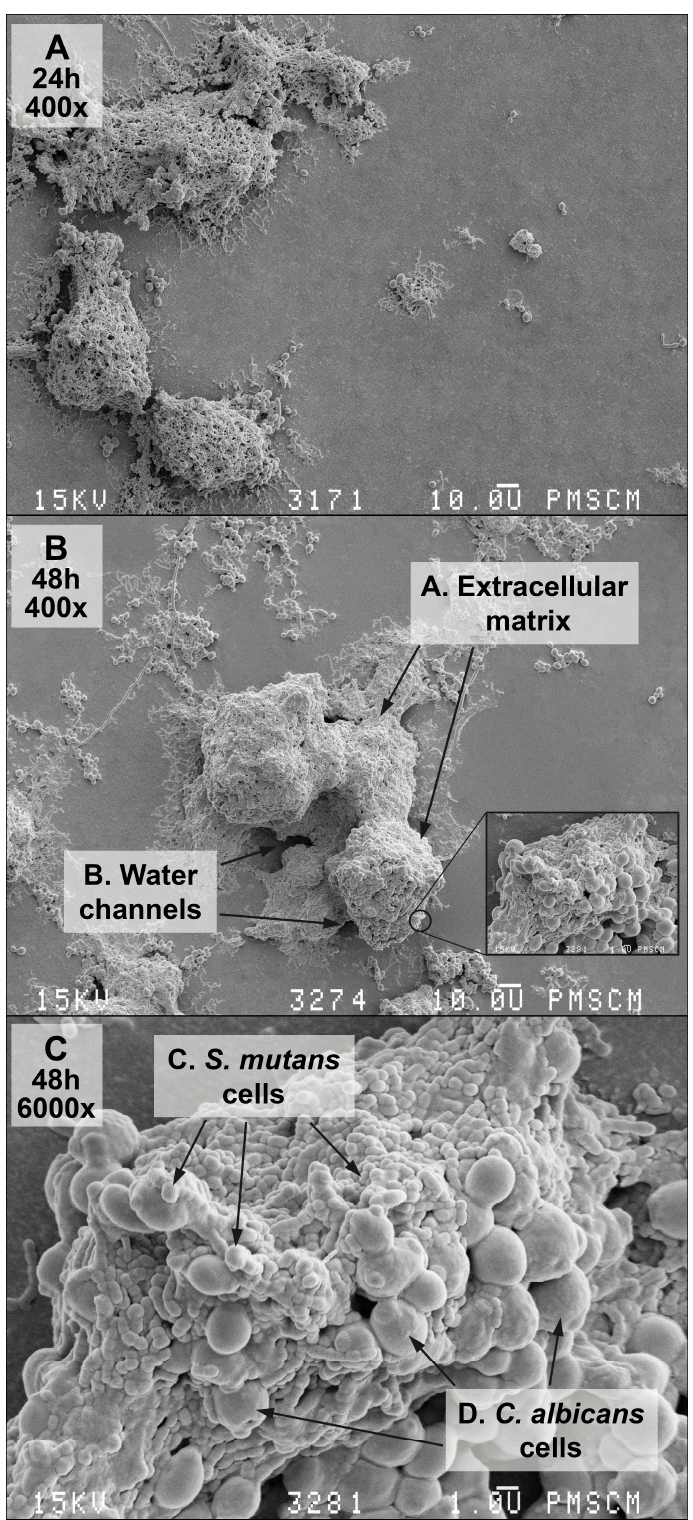
Figure 2. Scanning electron microscopy (SEM). ( A – C ) images of the double-species biofilm formed by C. albicans and S. mutans , after 24 ( A ) and 48 ( B , C ) h of biofilm formation. Culture was maintained at 37 °C, pH 7.0 and pCO 2 5%, in bovine serum as a medium additive promoting the growth of the culture in the presence of a sucrose substrate (5%). Original magnification: 400× and 6000×.